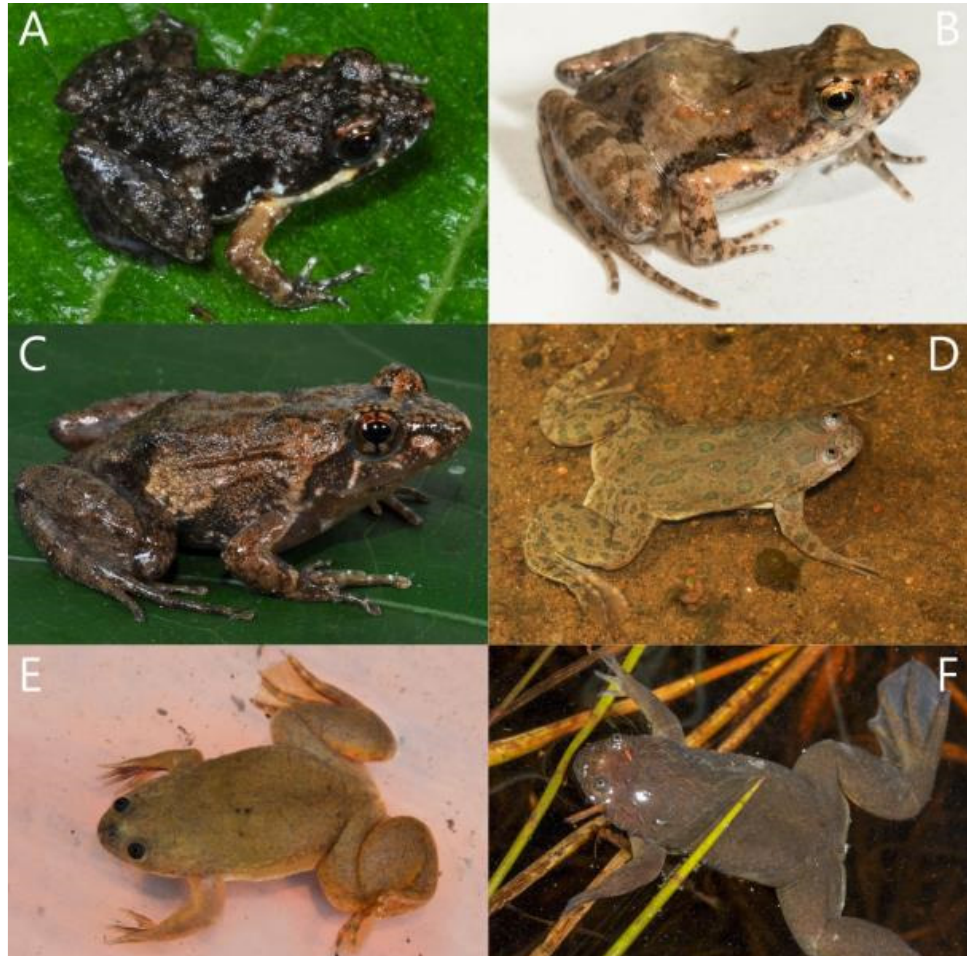
Figure 12. Rwandan species of Phrynobatrachidae ( A ) Phrynobatrachus parvulus , Saruhembe, Eastern Province (photo: J.M.D.), ( B ) Phrynobatrachus scheffleri , Akagera NP (photo: J.M.D.), ( C ) Phrynobatrachus versicolor , Nyungwe NP (photo: J.M.D.); and Pipidae ( D ) Xenopus muelleri , Bugarama (photo: J.M.D.), ( E ) Xenopus victorianus , Huye (photo: J.M.D.), ( F ) Xenopus wittei , Nyungwe NP (photo: J.M.D.).